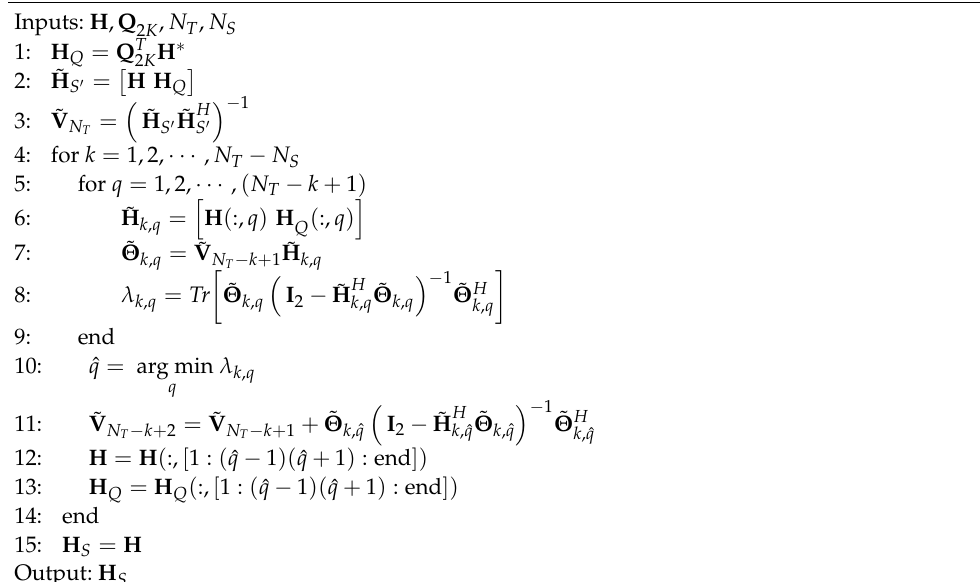
Algorithm 4 Proposed ZF-based efficient decremental TAS selection